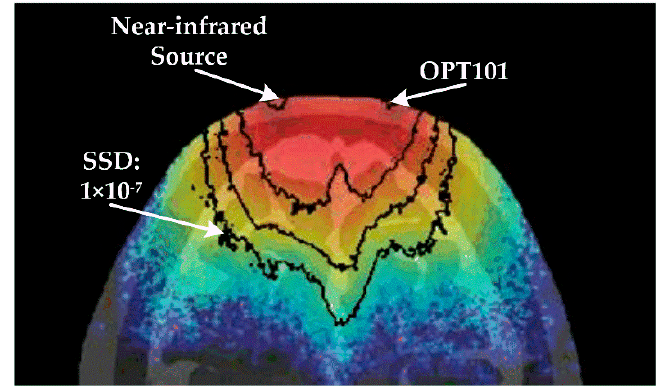
Figure 2. Signal sensitivity contour map.